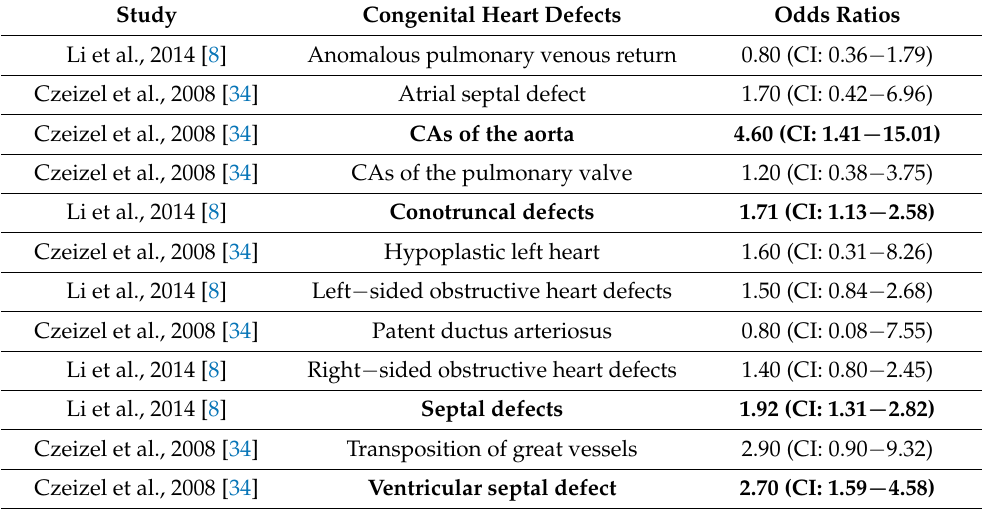
Table 2. Unadjusted odds ratios for developing specific types of congenital heart defects after influenza infection in the first trimester.